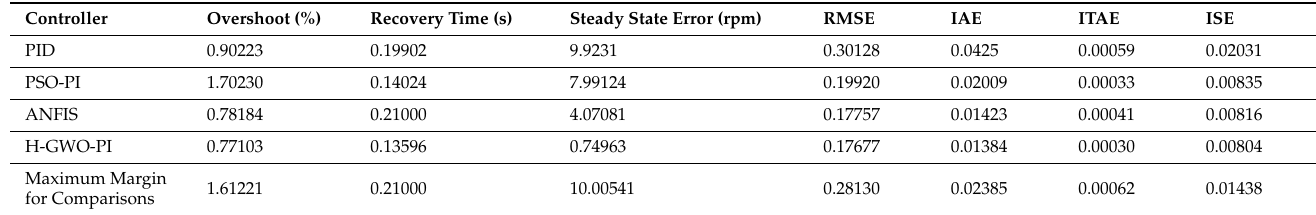
Figure 14. Response of the Brushless DC motor in terms of speed under Case D. Table 6. Performance parameters for Case D condition.